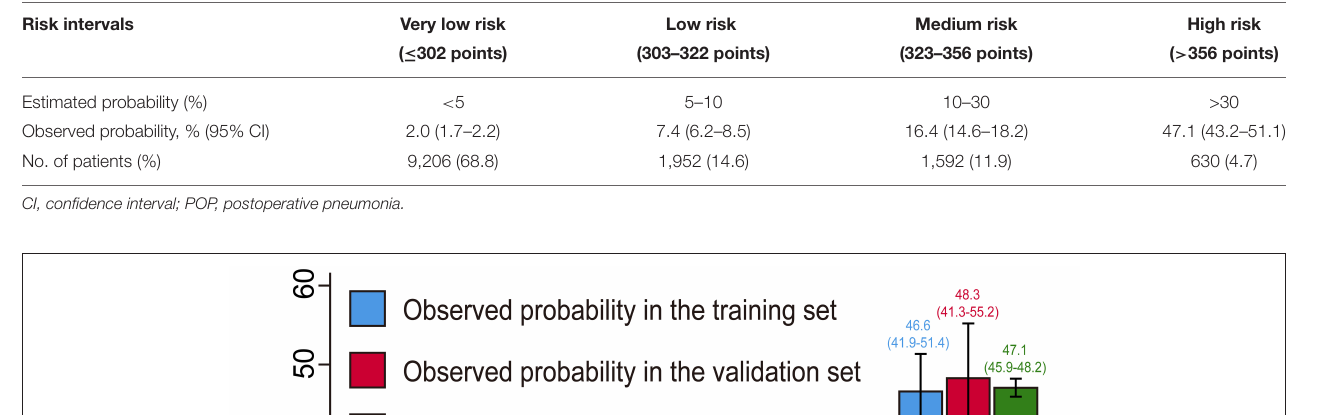
TABLE 5 | Risk intervals of POP based on the full nomogram model.